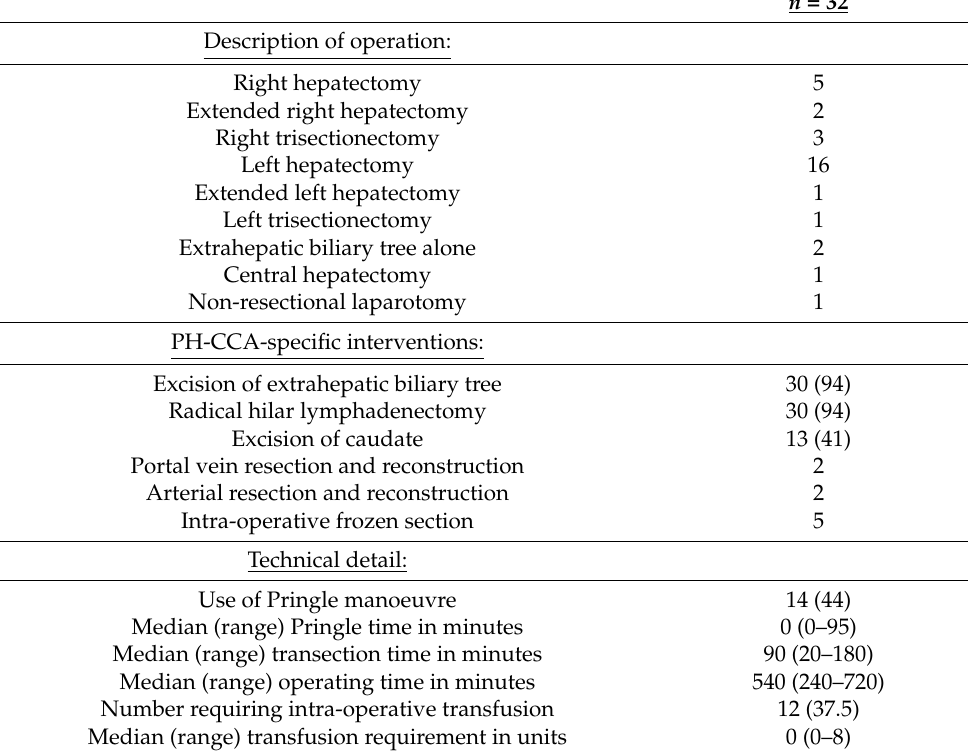
Table 2. Operative detail.